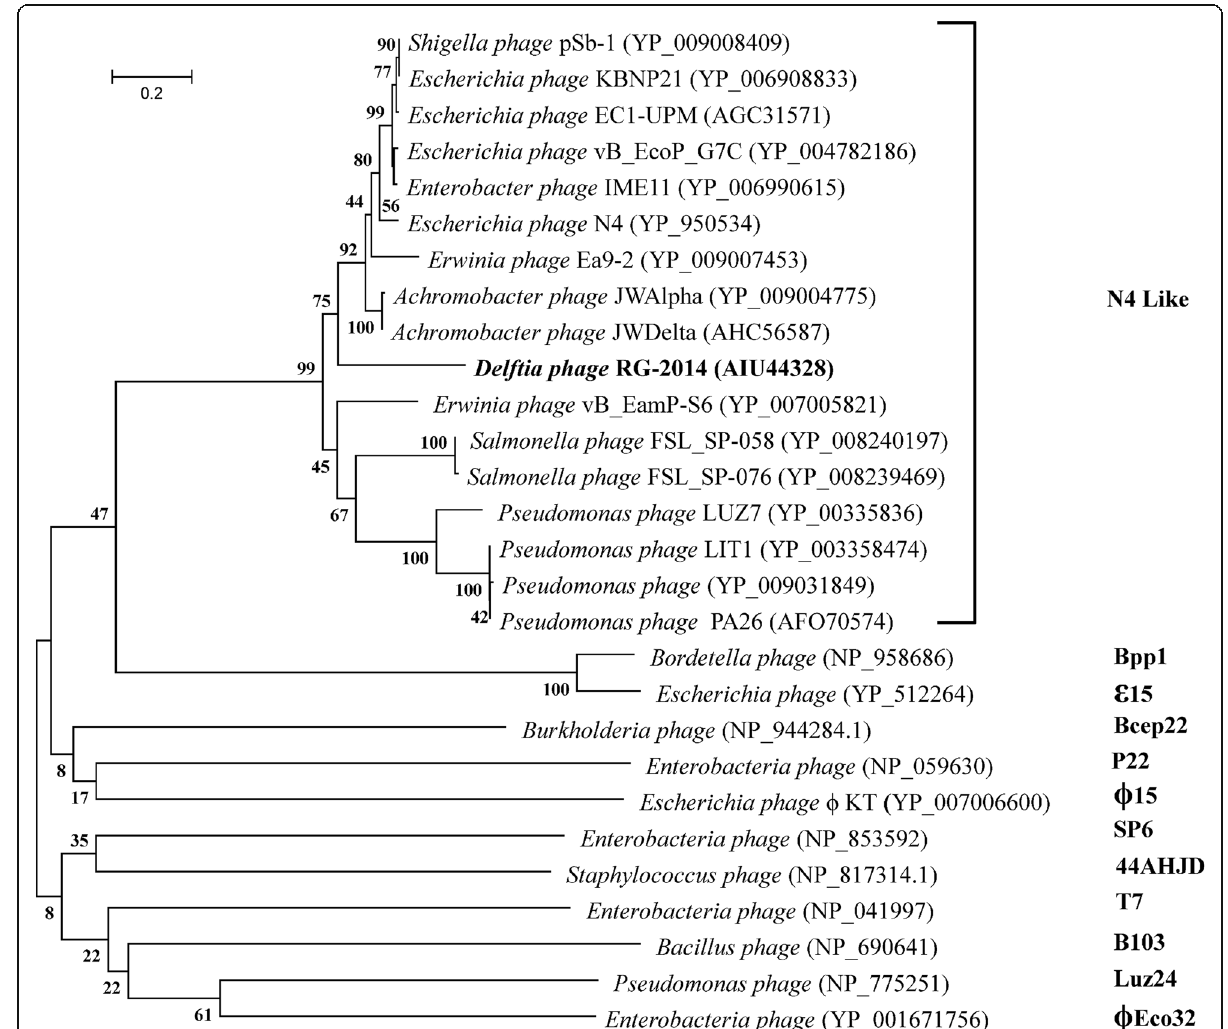
Fig. 2 Phylogenetic tree highlighting the position of major coat protein of phage RG-2014 relative to major coat proteins of other hosts. The corresponding GenBank accession numbers for each phage coat protein is indicated in parenthesis. Eleven other types of Podoviridae are included below the N4-like group for comparison. The tree construction used MUSCLE model to align the protein sequences by MEGA (v.5), and the Maximum-likelihood algorithm to construct a distance matrix based on alignment model positions using bootstrap method with 1000 bootstrap